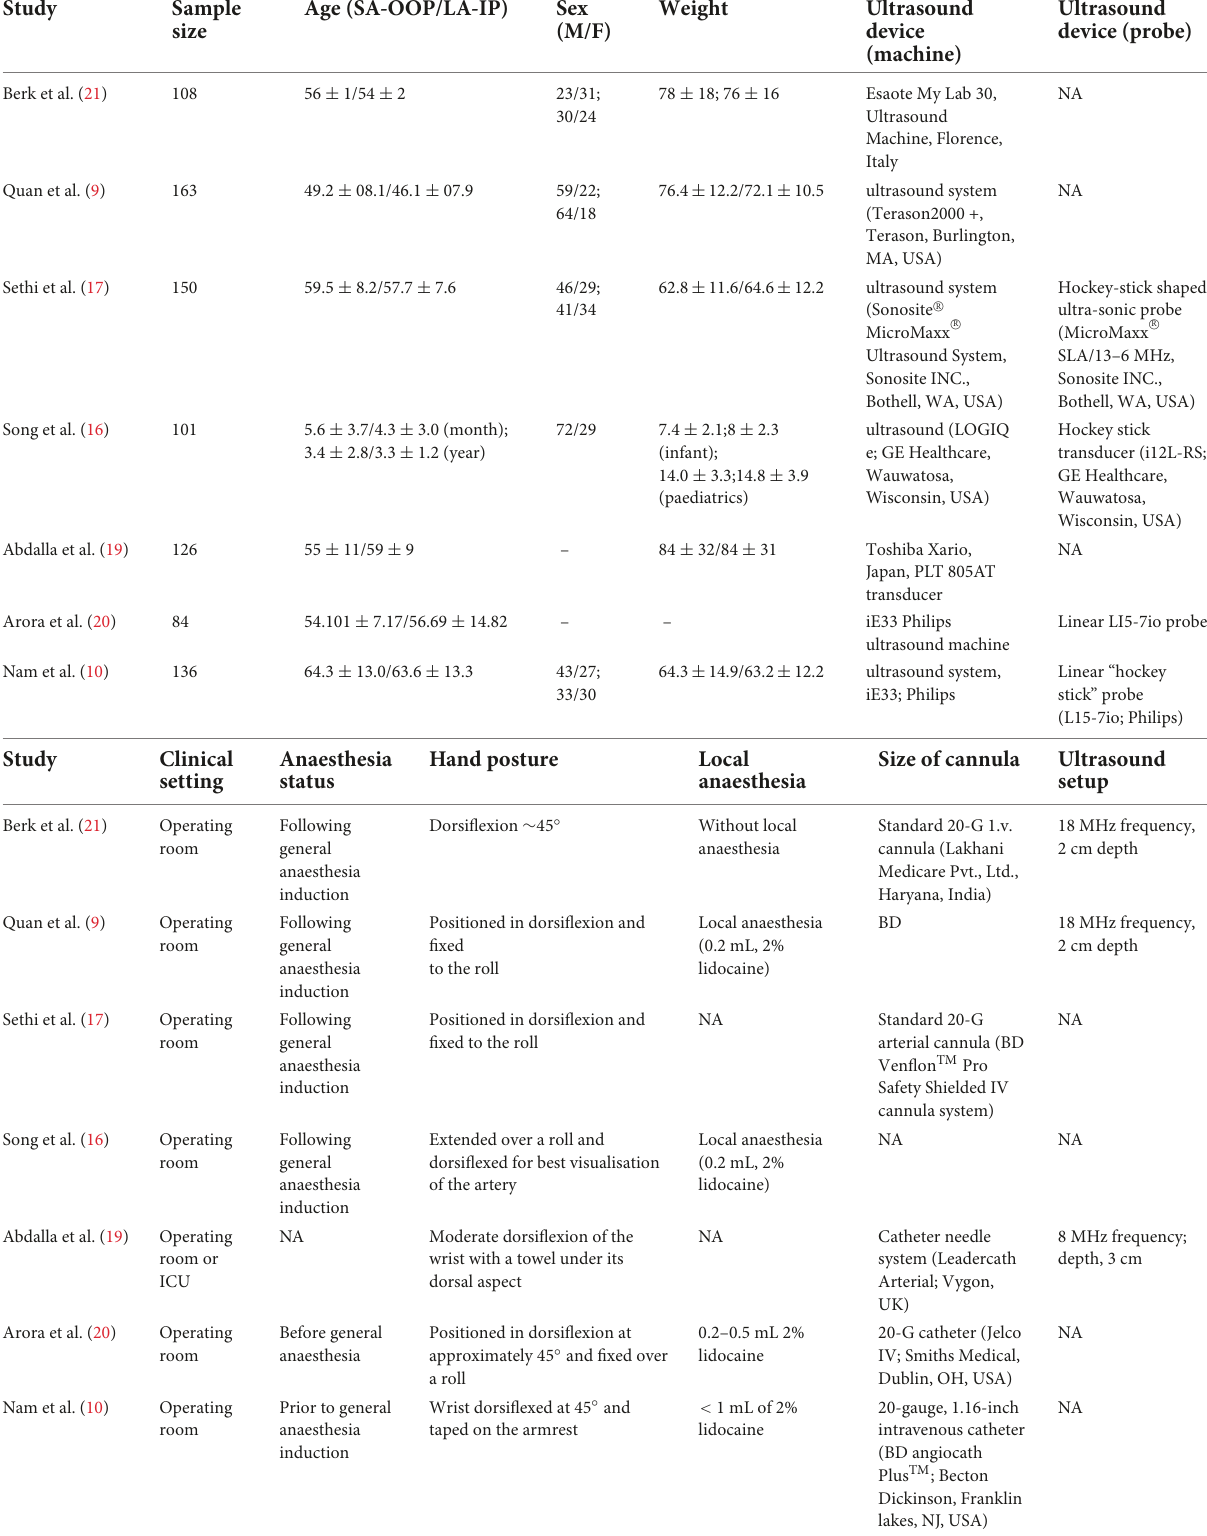
TABLE 1 Characteristics of included